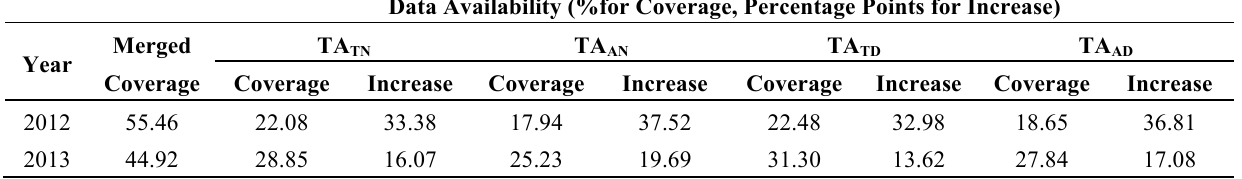
Figure 8. Percentages of data availability for daily mean air temperature ( TA ) in 2012 and 2013 for merged images based on the validation dataset. Table 8. Percentages of the daily mean air temperature ( TA ) images for the merged dataset (all four MODIS LST products combined using strategy 2 in Table 6) and for images derived from daytime and nighttime TERRA and AQUA MODIS LSTs in 2012 and